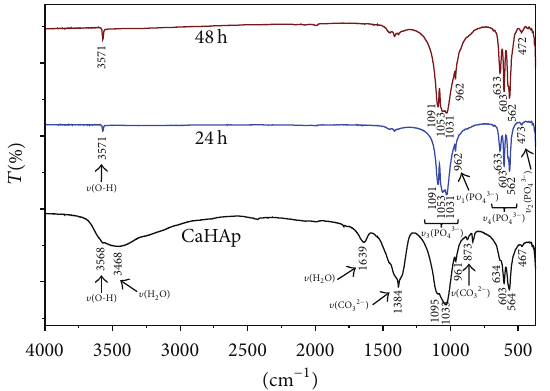
Figure 6: IR spectra of CaHAp before refluxing and after refluxing in lead nitrate solution (917 mg/L) for 24 h and 48